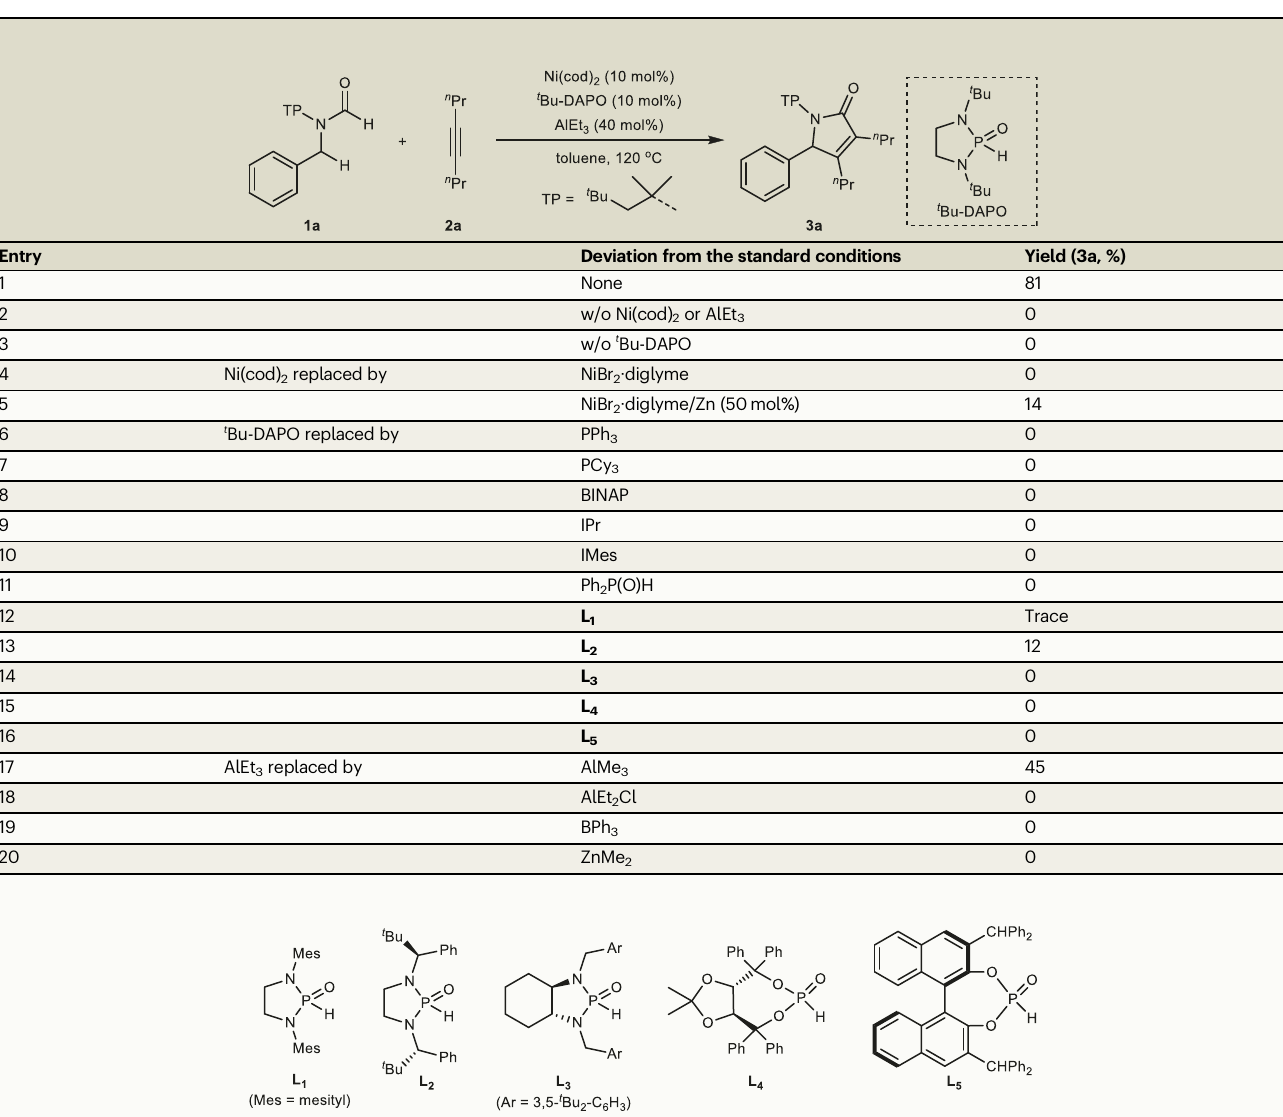
Table 1 | Reaction